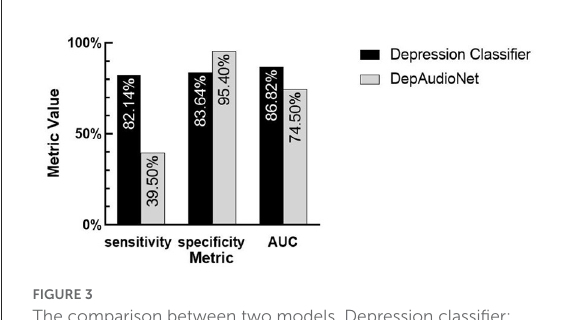
FIGURE4 Correlation between proportion and HAMD score. Relationships between severity of MDD evaluated by HAMD score and proportion graded by AI models, for participants with MDD ( N = 56, depression group) and healthy controls ( N = 47, control